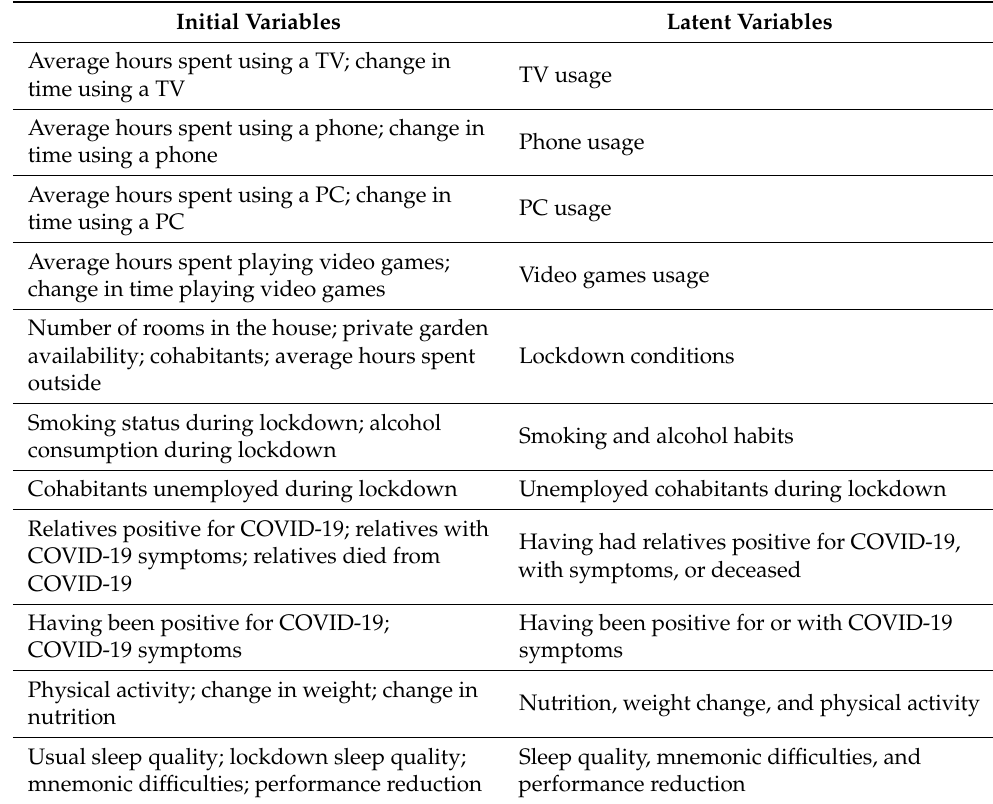
Table 3. Collected variables and latent